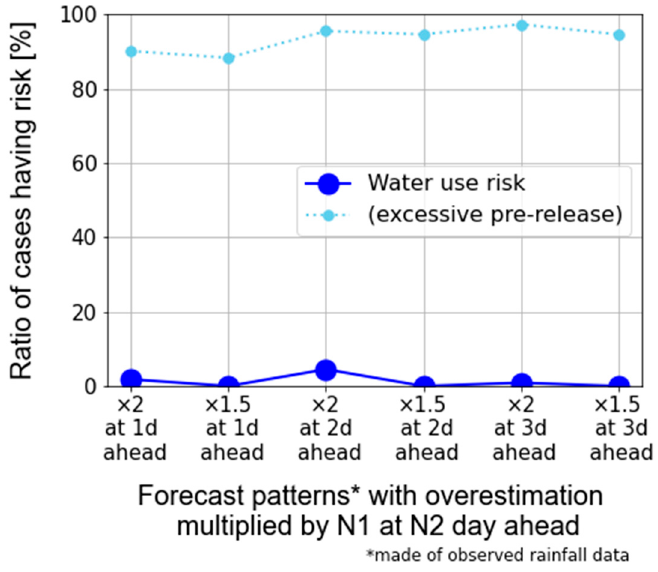
Figure 18. Ratio (%) of cases with a water use risk when using variously overestimated rainfall forecasts for all pre-release cases and quasi-pre-release cases (in blue). Ratio of cases implementing excessive pre-release beyond what is necessary is included (in light blue).